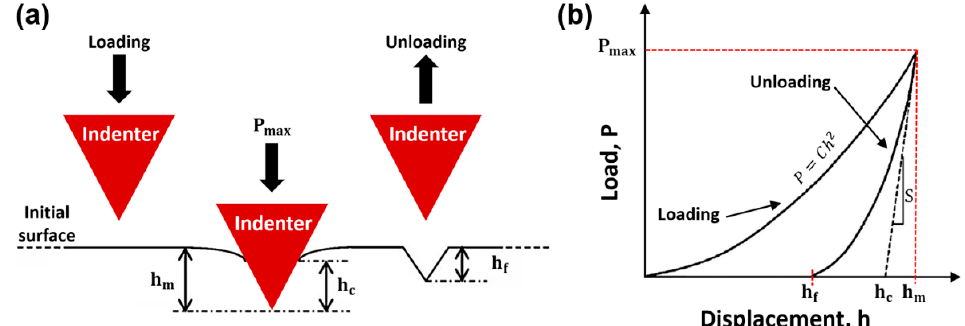
Figure 4. ( a ) Schematic representation of the interaction between Berkovich indenter tip and the sample (Oliver and Pharr, 1992): Pmax—maximum applied load; ℎ (cid:3040) — maximum depth; ℎ (cid:3030) — con- sample (Oliver and Pharr, 1992): Pmax—maximum applied load; h m —maximum depth; h c —contact tact depth; ℎ (cid:3033) — final depth. ( b ) A typical load–displacement indentation curve. depth; h f —final depth. ( b ) A typical load–displacement indentation